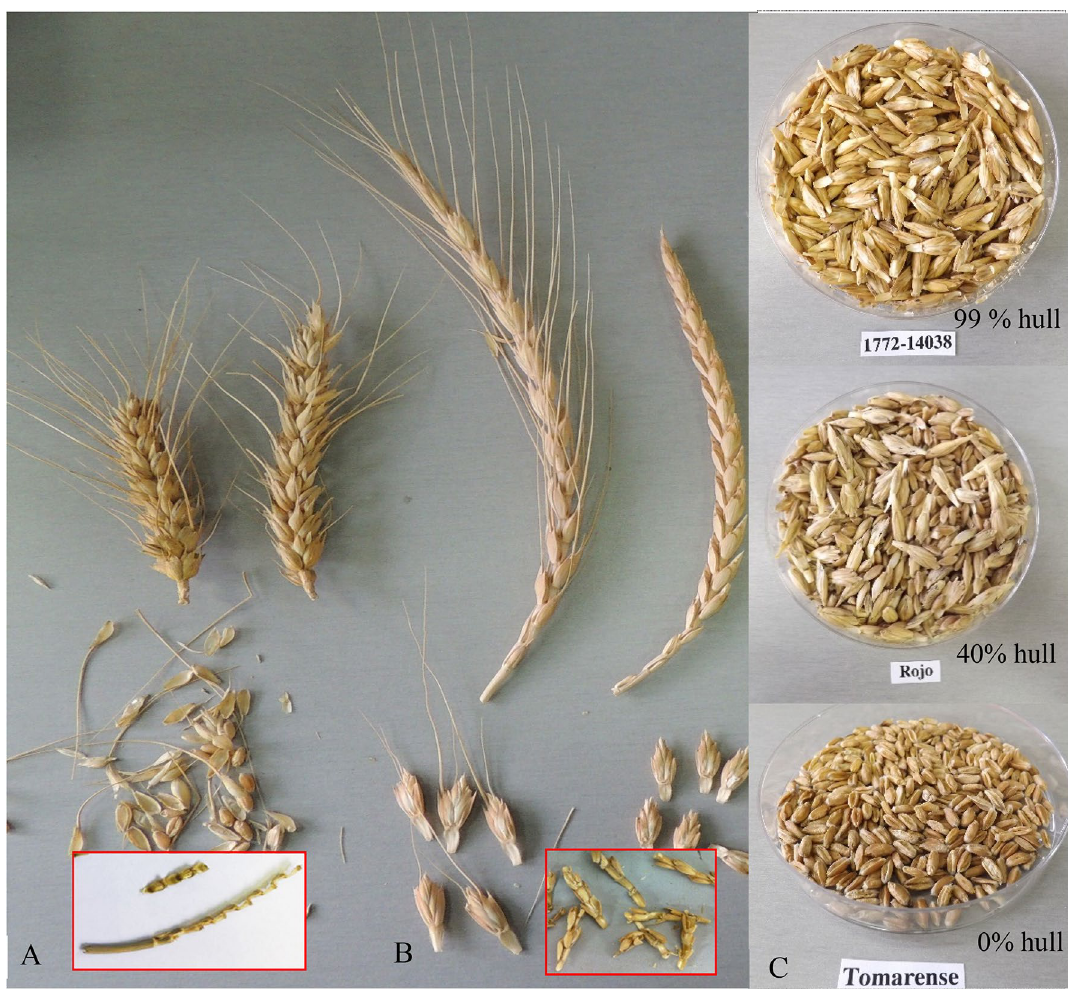
Figure 3. Spike morphology and threshing characteristics of ( A ) Bread wheat, complete spike (upper), threshed spike (middle) and rachis (highlighted red colour square) ( B ) Spelt complete spike (upper), threshed spike (middle) and Rachis (highlighted red colour square) and ( C ) Spelt hullness 1772–14308 (PI 191617) around 99% hullness (upper), Rojo (PI 191100) around 40% hullness (middle), Tomarense (PI 608792) free threshing